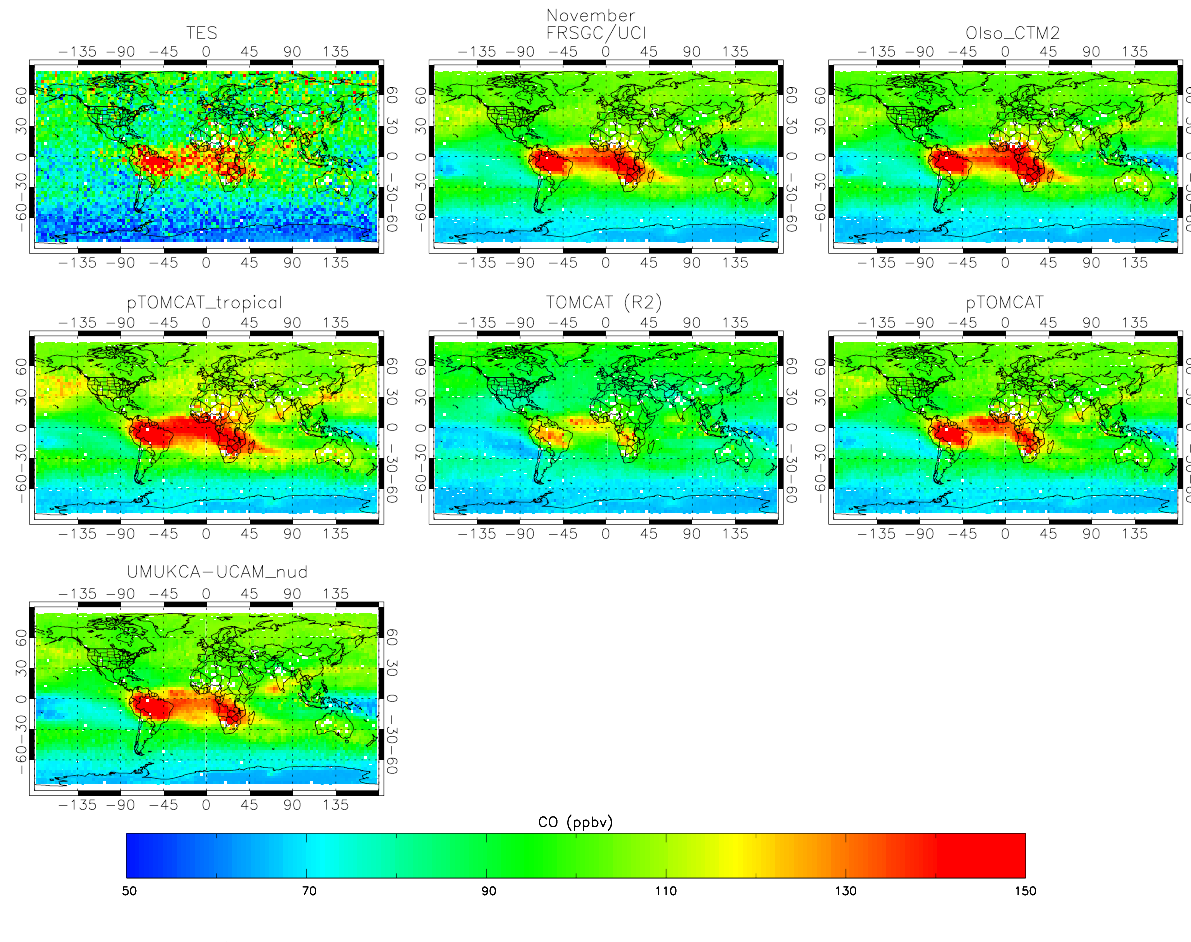
Fig. 13. As in Fig. 11, but for November